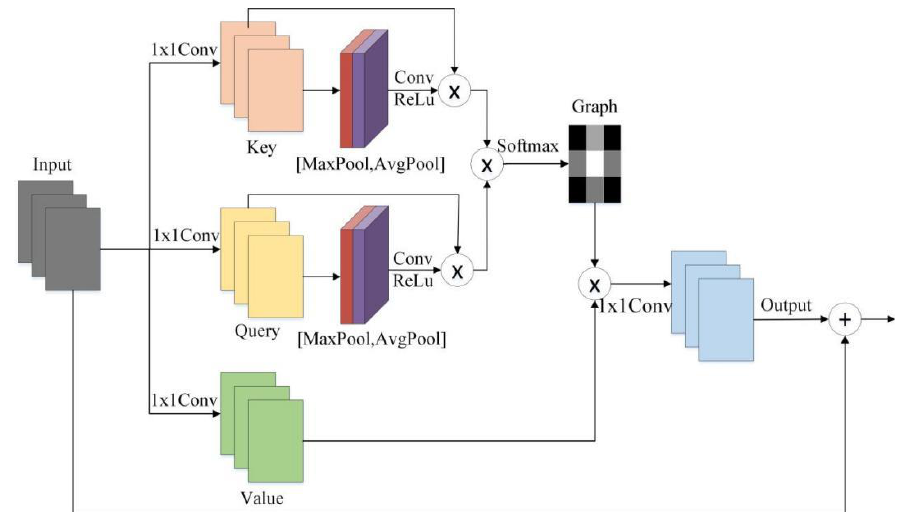
Figure 9. Self-attention mechanism with spatial self-attention.